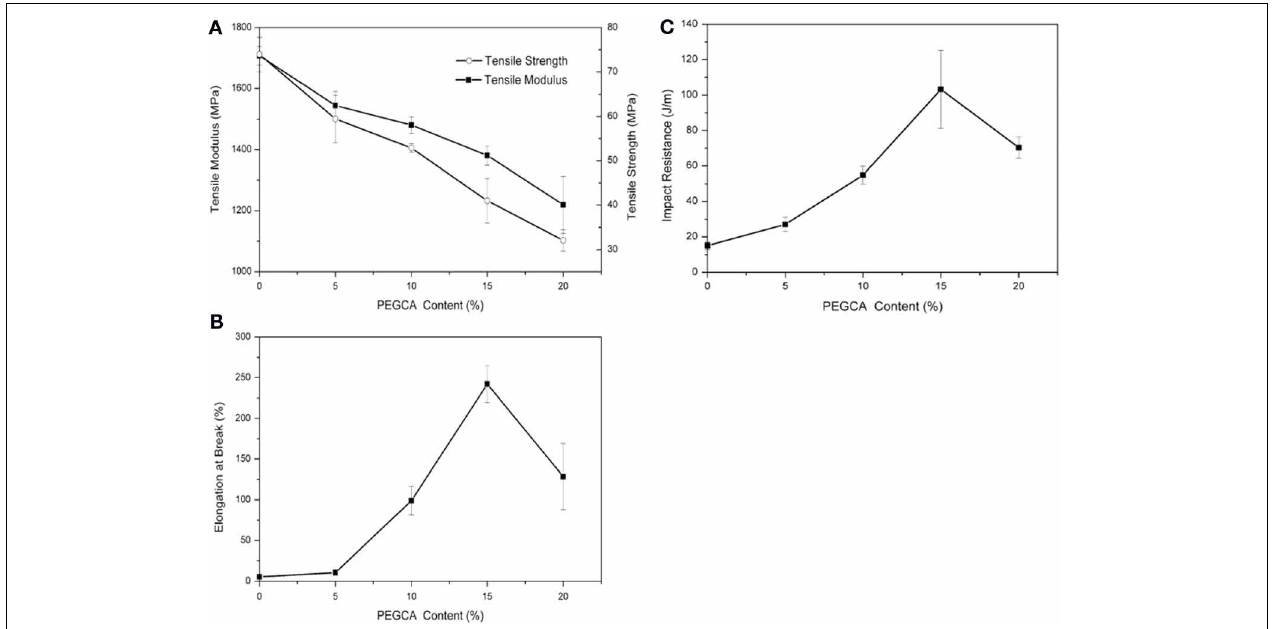
FIGURE 2 | (A) Tensile modulus, tensile strength, (B) elongation at break, and (C) of neat PLA and PLA/PEGCA blends (Gui et al., 2013, original copyright with kind permission from Springer Science and Business Media).